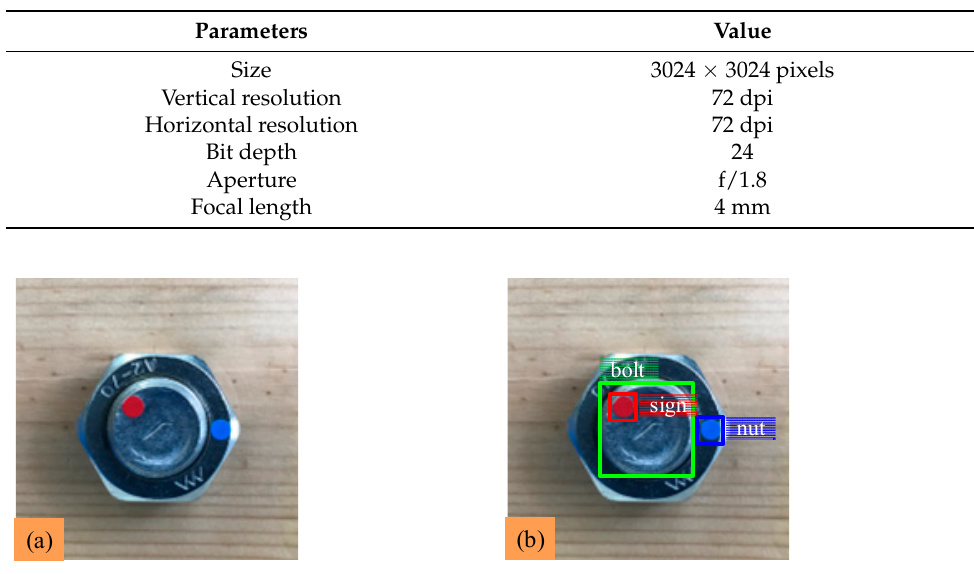
Figure 4. Labeling of the dataset: ( a ) captured bolt image; ( b ) labels of three classes. The dataset contains three classes, namely ‘bolt’, ‘nut’ and ‘sign’. The YOLOv5 algorithm under the Pytorch framework was used to train the dataset. Then, the YOLOv5 can identify and locate the three classes and output the center coordinates of the three classes’ predicted boxes. As shown in Figure 5, the top left corner of the image is taken as the origin, the center of the ‘bolt’ class is known to be A ( x 1 , y 1 ) , the center of the ‘nut’ class is B ( x 2 , y 2 ) and the center of the ‘sign’ class is C ( x 3 , y 3 ) . Based on these coordinates, the angle can be calculated by the vector product.